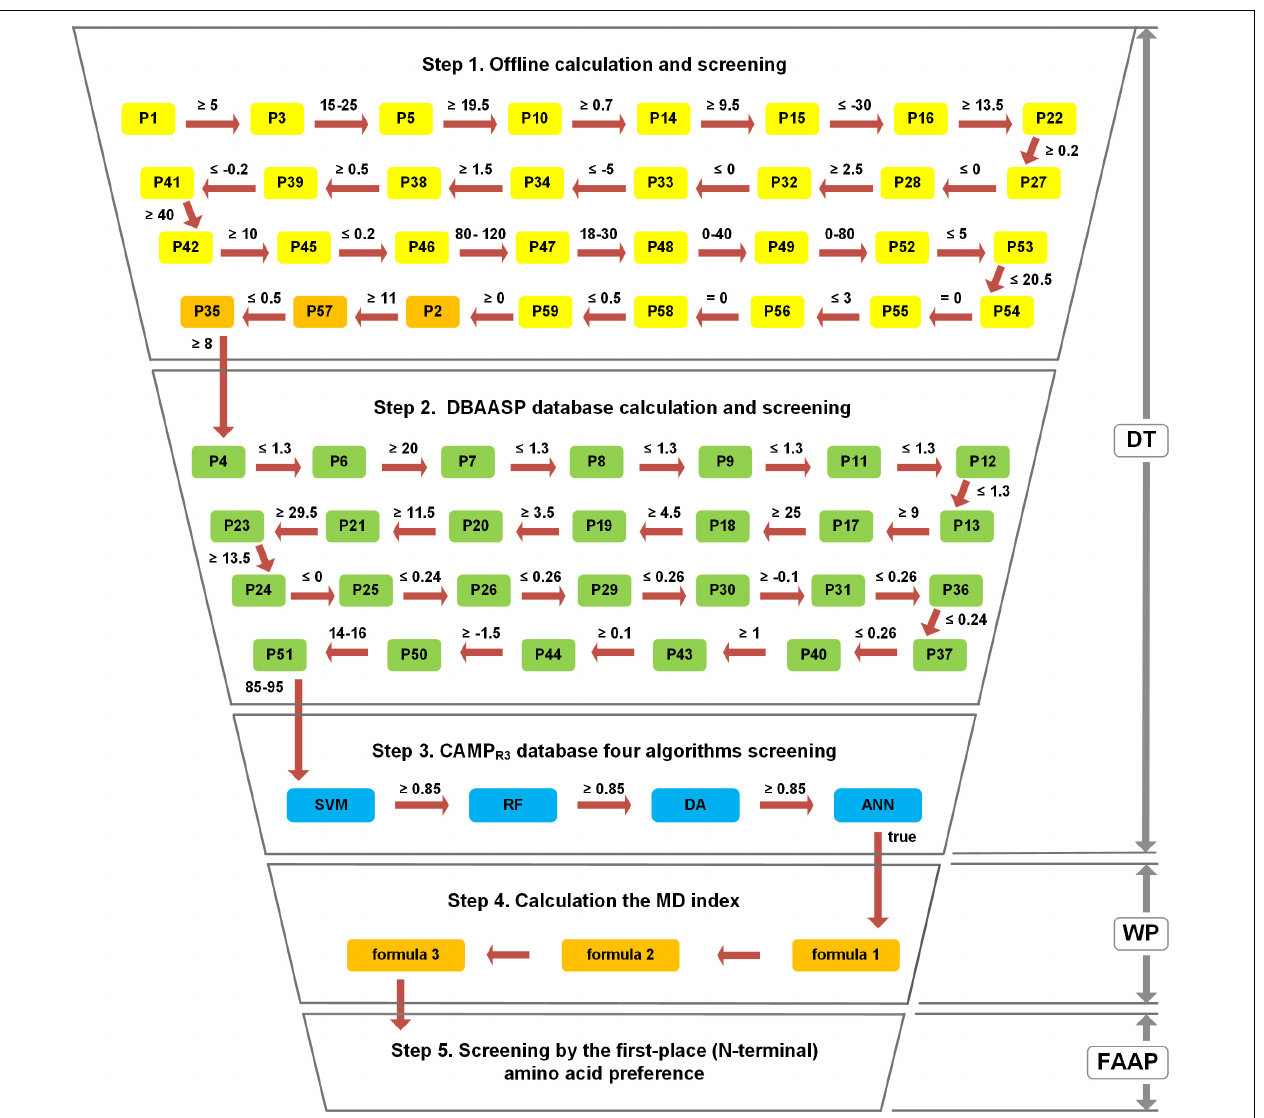
FIGURE 1 | The workflow of the Multiple Descriptor Multiple Strategy (MultiDS) screening system. DT represents a decision-tree-like screening model, including three steps of offline calculation and screening, DBAASP database calculation and screening, and four algorithms screening by CAMP R3 . WP represents the weighted point method, which was taken as the theoretical basis to construct the MD index through three calculation formulas. FAAP represents the first-place amino acid